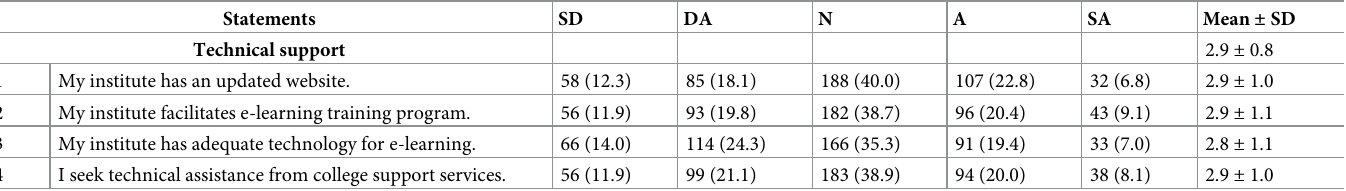
Table 6. Technical support (n = 470).